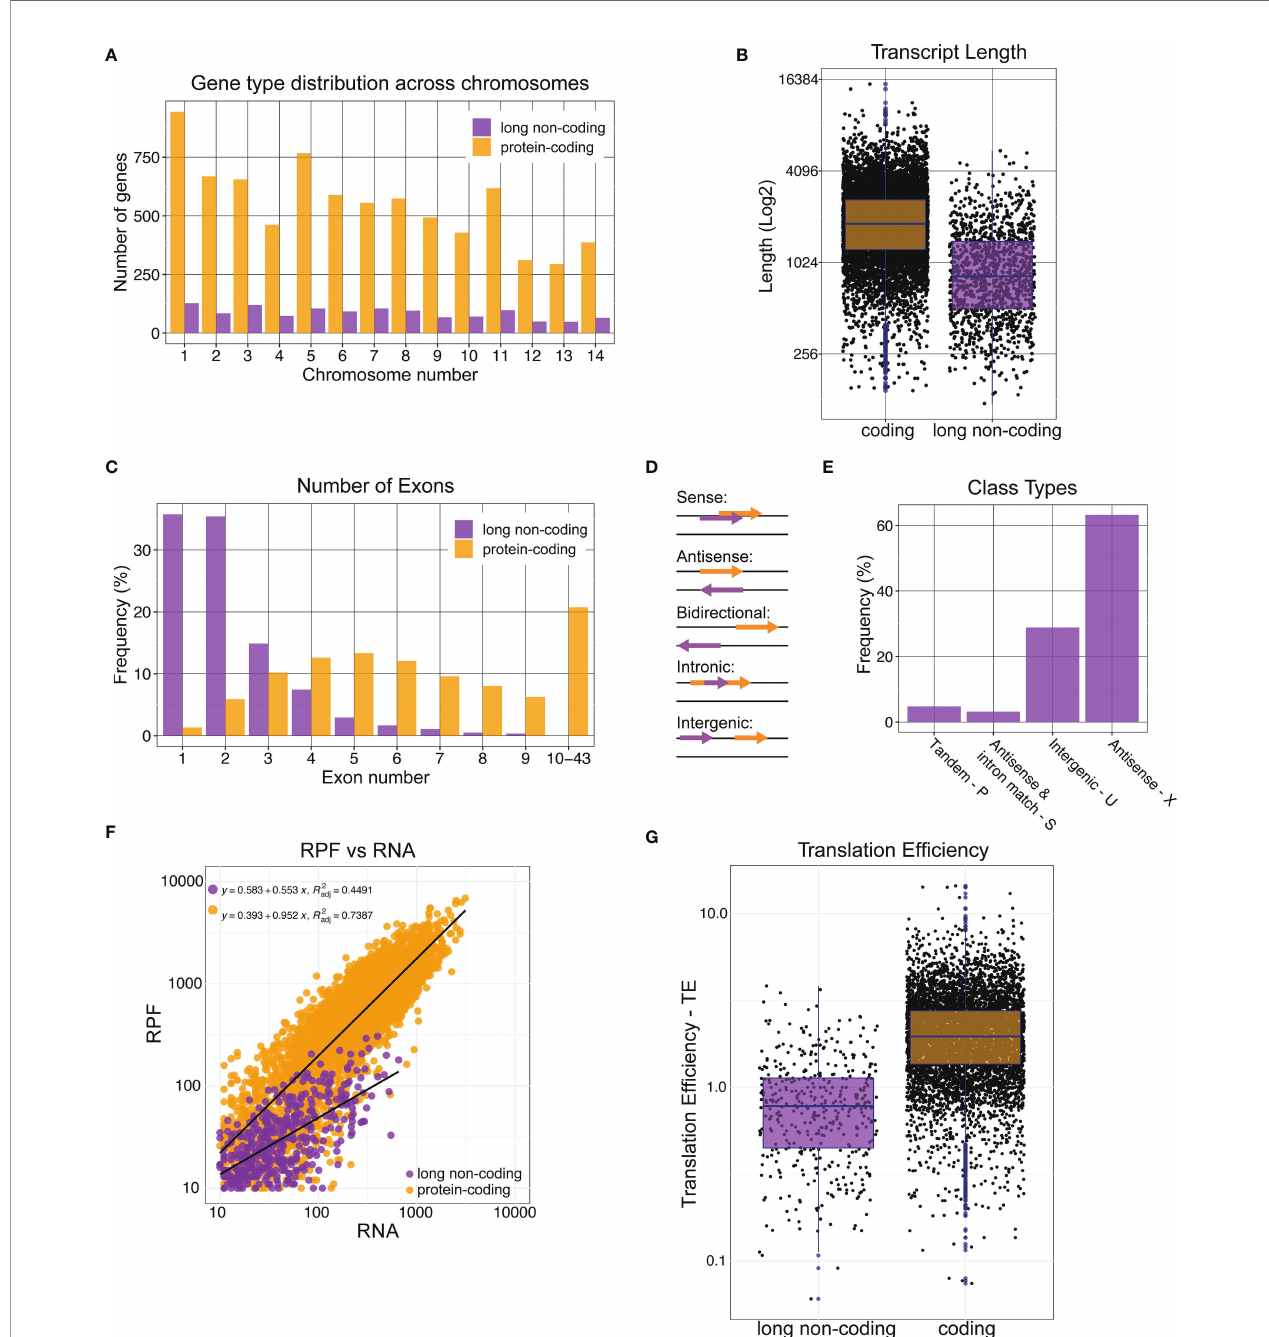
FIGURE 1 | Characterization of annotated long non-coding RNAs in Cryptococcus neoformans . C. neoformans (strain H99) non-coding RNA sequences were obtained from FungiDB. We investigated the genomic locations of lncRNAs across chromosomes (A) , transcript length (B) , and the number of exons (C) . LncRNAs are classi fi ed based on their juxtaposition relative to protein-coding genes. We determined the lncRNA class types using the GffCompare program (D, E) . We investigated the occupancy of lncRNAs by ribosomes by plotting ribosome-protected fragments (RPF) vs. RNA abundance using a 10 reads minimum threshold. Regression analysis, shown as black lines, and corresponding equations with R 2 values are also presented (F) . Translation ef fi ciency was calculated by using the RPF/RNA formula and plotted for both coding and non-coding RNAs (G) . Ribosome pro fi ling data is obtained from GSE133125. Bed fi les supplied by the authors were utilized to obtain the coding and non-coding transcript